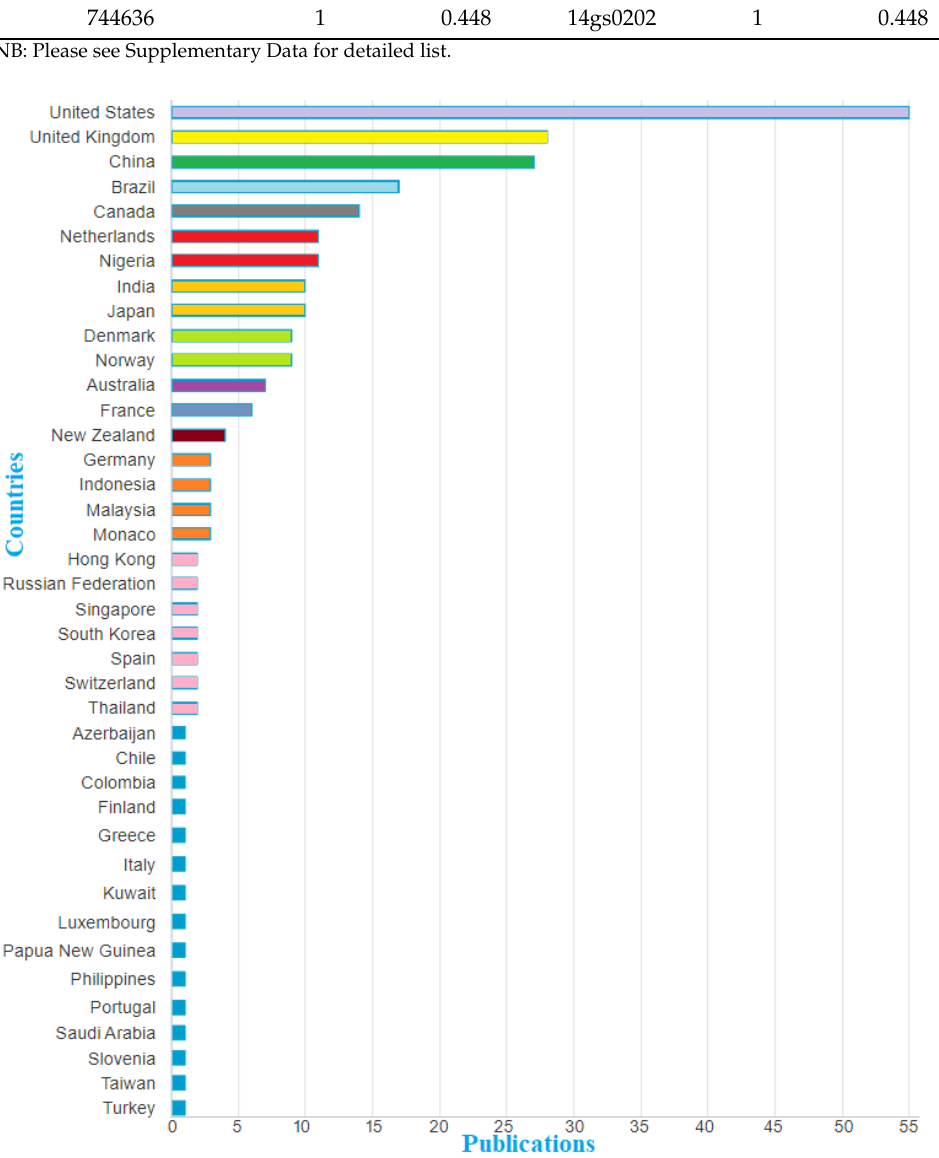
Figure 13. The research on “marine hose” research (data retrieved from Scopus database, 24 July 2022).